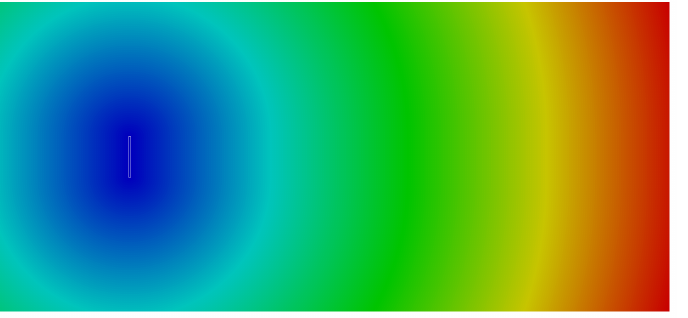
Figure 3. Level set function for a test case featuring one turbine. The range of the illustrated level set field is [ 0,700 ]